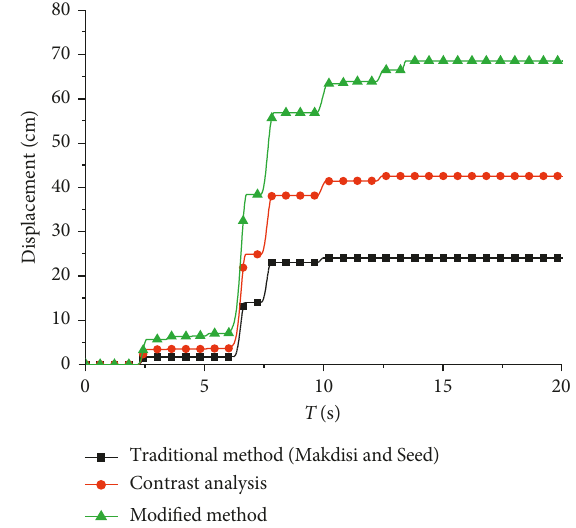
Figure 6: Time history sliding